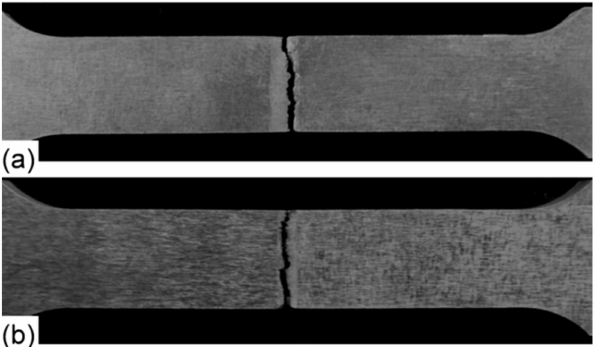
Figure 13. Photographs of tensile fractured specimens of the low ( a ) and high ( b ) heat input welds.